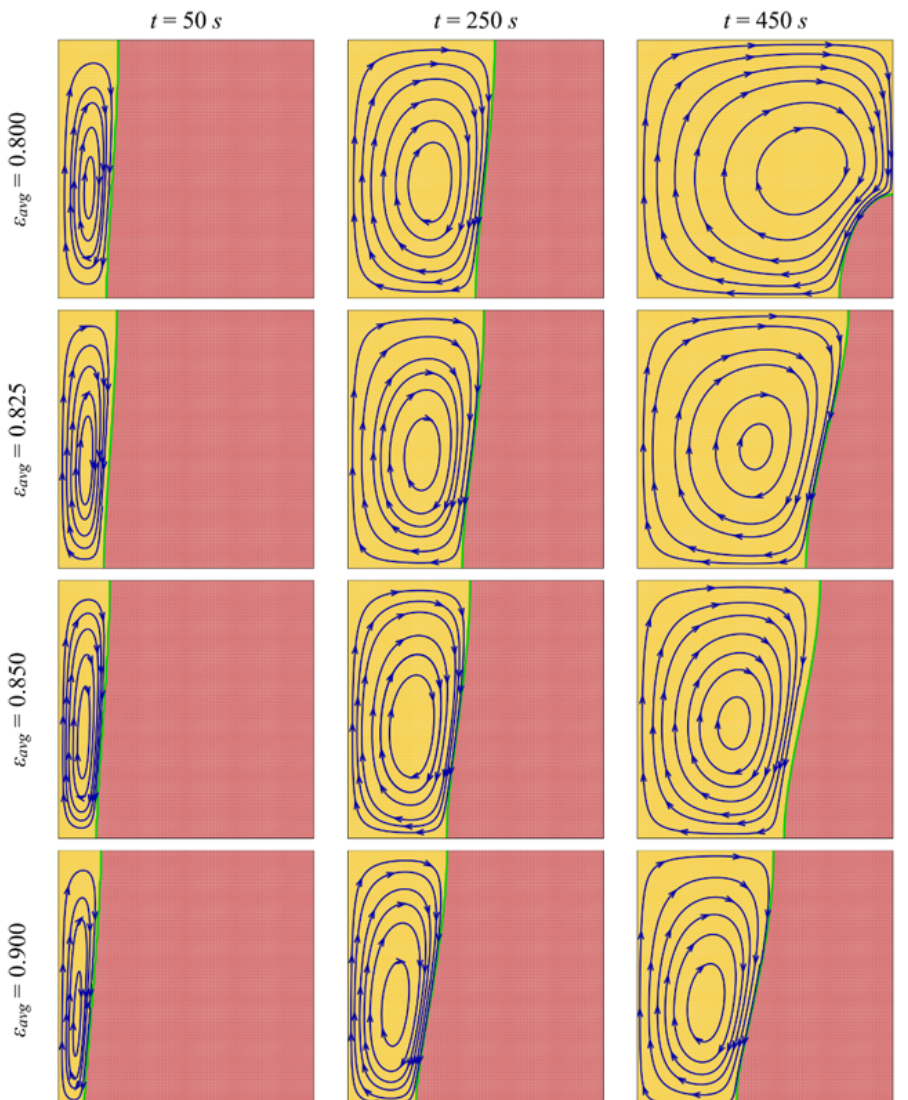
Figure 5. Stream lines and melting interface (green solid line) at three different times for various average porosities when VF na = 0.01, a = − 2, γ = 2 π /4, and PPI =